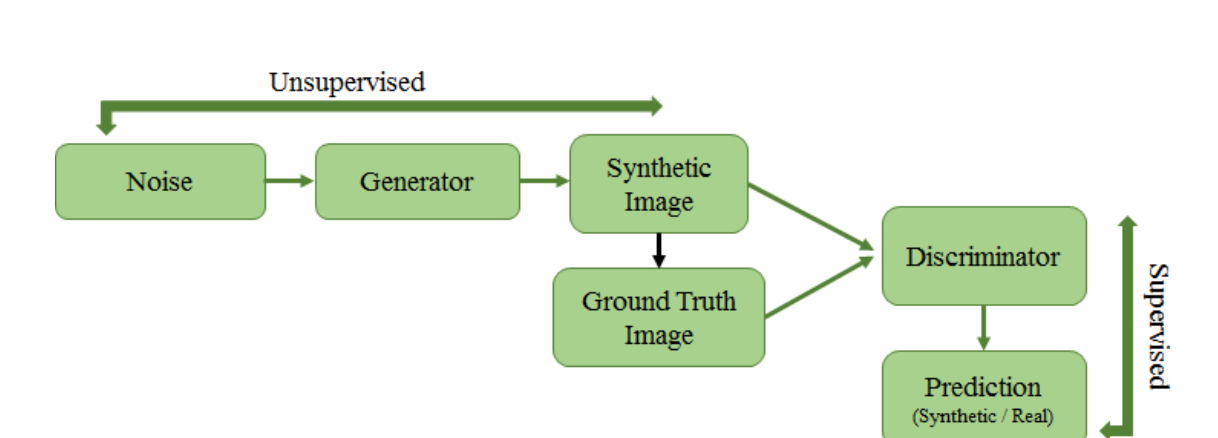
Figure 10. Architecture of GAN. The GAN comprises two networks: generator and discriminator. Generator synthetically generates images by adding noise, this is an unsupervised task. Discriminator tries to find whether images generated by the generator are real or fake as a supervised task. Both these networks compete against each other and gradually learn to produce better